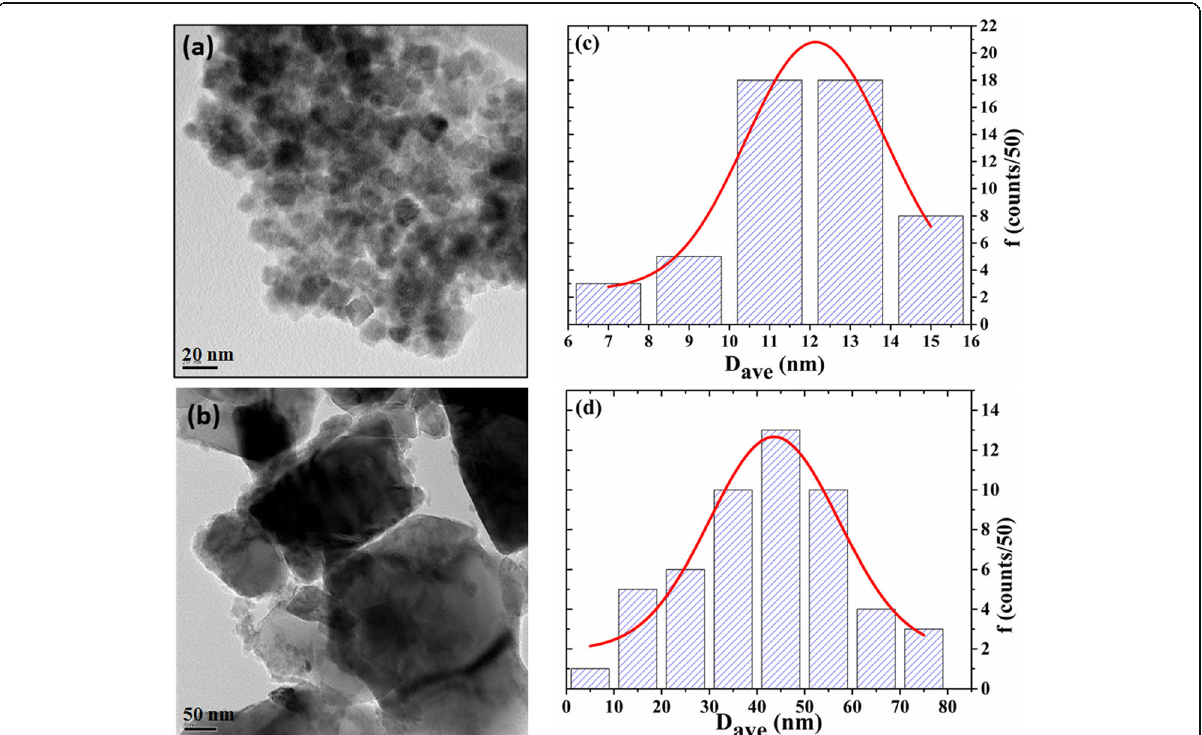
Fig. 3 TEM image and size distribution histogram of prepared Fe 3 O 4 nanoparticles a , c before annealing and b , d after heating to 900 K (the red solid lines at c and d are the normal